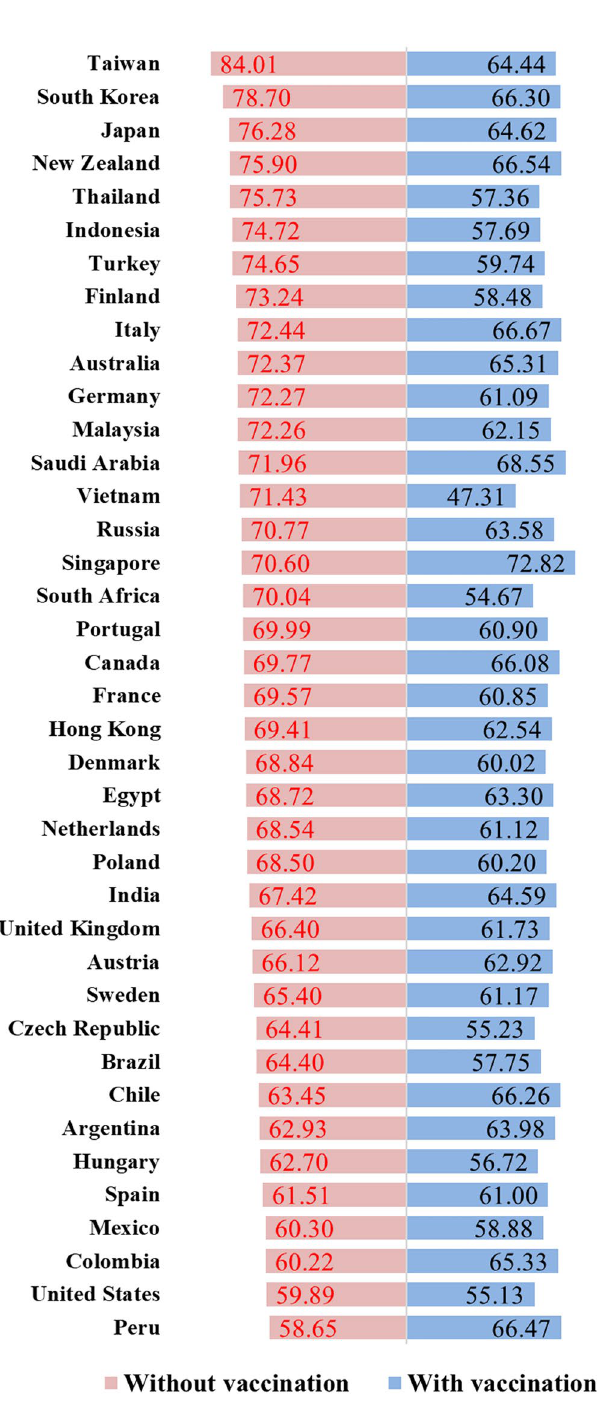
Figure 2. Average of performance scores in pre-vaccine and vaccine phases of the study. Nine and ten indicators (including Google Trends data) were used to obtain performance scores in pre-vaccine and vaccine phases of the study, respectively. Note that countries/territories with missing data were